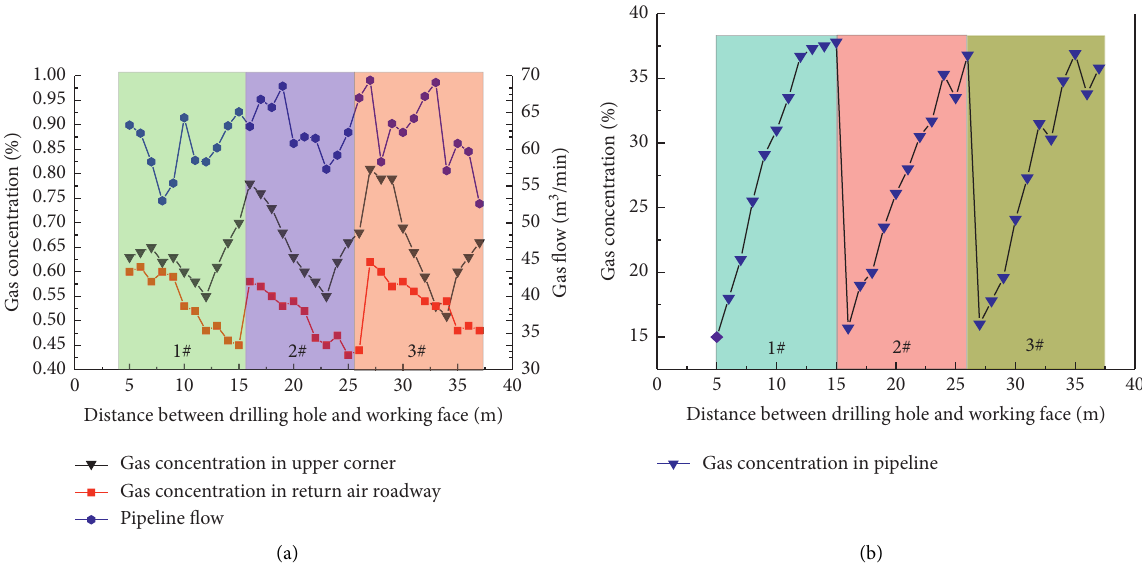
Figure 8: Variation of gas concentration in the upper corner, borehole, and return air roadway with the advance of the working face under drainage